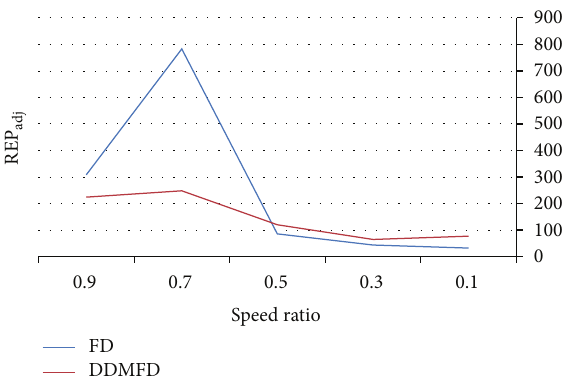
Figure 15: Average of REP parameter.